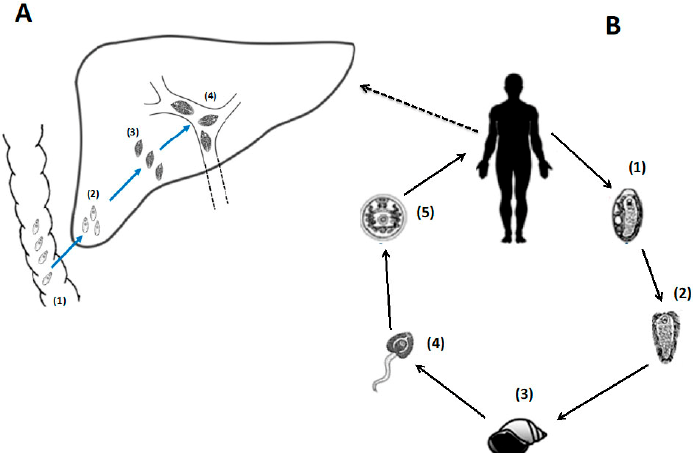
Figure 1. Fasciola hepatica lifecycle. Graphical representation of the F. hepatica lifecycle (adapted from [82]). ( A1 ) parasite excyst in the intestine of the mammalian host, releasing newly excysted juveniles (NEJ) that migrate across the intestinal wall, through the peritoneal cavity to the liver ( A2 ). NEJ migrate through the liver parenchyma, increasing in size to juvenile flukes as they migrate into the bile ducts ( A3 ), where they grow and develop into fully mature adults ( A4 ); ( B1 ) eggs are released in the faeces and develop on vegetation; ( B2 ) a single miracidium hatches from each embryonated egg and then ( B3 ) infects the intermediate snail host ( Galba truncatula ); ( B4 ) within the snail, the parasite develops through the sporocyst, rediae and cercariae lifecycle stages. Cercariae are released from the snail and ( B5 ) encyst on vegetation as dormant metacercariae, which are subsequently ingested by the definitive host.